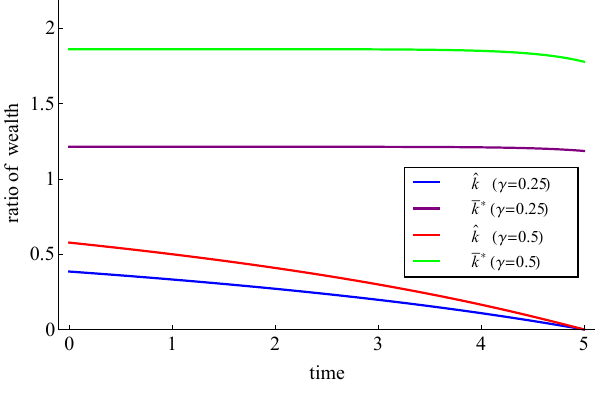
Figure 1. Optimal pre- and post-crash strategies for ρ = 0 . 5 .